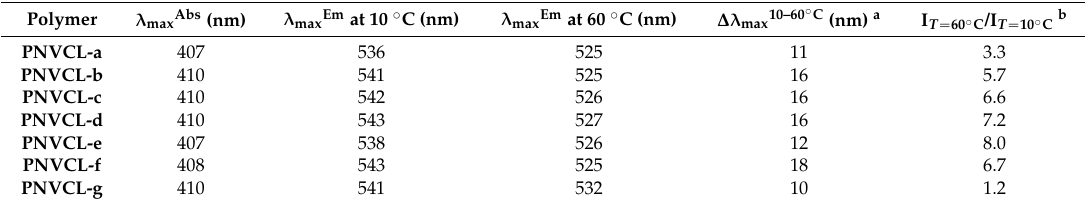
Table 4. Spectral characteristics of the dye-labeled PNVCL polymers in aqueous solution (concentration 0.10 g ¨ L ´ 1